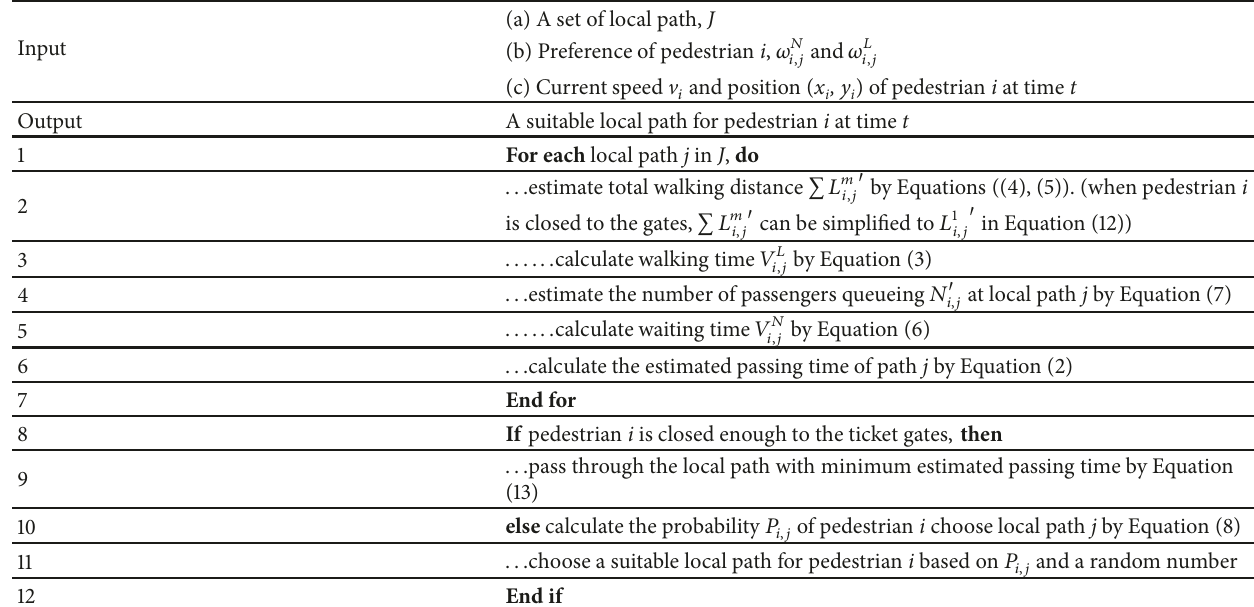
Figure 9: The locations to make the multistage route choices. Table 1: Algorithm of local route